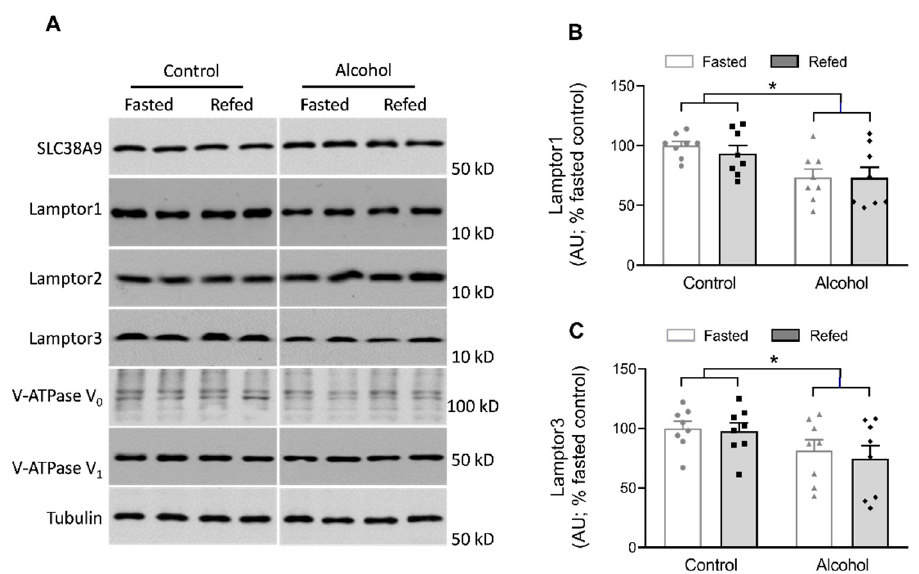
Figure 5. Alterations in Ragulator complex subunits after refeeding in the muscles of control and alcohol-receiving mice. ( A ), representative immunoblots for each. With the exception of LAMPTOR1 and LAMPTOR3, none of the proteins shown demonstrated a significant ( p > 0.05) alcohol effect using a 2-way ANOVA; hence, mean data are not shown. Although samples from all groups were loaded on the same gel, a gel break depicts lane(s) of the gel that have been deleted. ( B , C ) are bar graphs of all immunoblots for LAMPTOR1 and LAMPTOR3 that showed an alcohol effect on the abundance of these two proteins. Bar graphs represent analyses for all immunoblots, where the mean of the fasted saline-treated control group was arbitrarily set at 100 AU. Values are mean ± SEM with n = 8/group. * p < 0.05, alcohol treatment effect compared to control values. In contrast, while a 2-way ANOVA indicated that there was a significant alcohol ef- fect on both LAMPTOR1 and LAMPTOR3 protein content in muscle ( p < 0.05; Figure 5B,C), there were also no changes in the relative abundance of the peripheral (V 1 ) and integral membrane-associated (V 0 ) domains of the vacuolar proton V-ATPase (v-ATPase), which functions as a proton pump in the muscle homogenate from alcohol-treated and/or refed mice (Figure 5A). When LAMPTOR1 was immunoprecipitated, refeeding of control mice increased the amount of Raptor bound to LAMPTOR1 and decreased the amount of RagC and v-ATPase V 0 bound to LAMPTOR1 (Figure 6A–D). In the fasted state, alcohol increased the binding of RagC and v-ATPase V 0 to LAMPTOR1. Finally, alcohol pre- vented alterations in the association of Raptor, RagC and v-ATPase V 0 to LAMPTOR1 af- ter feeding that were seen in refed control mice.